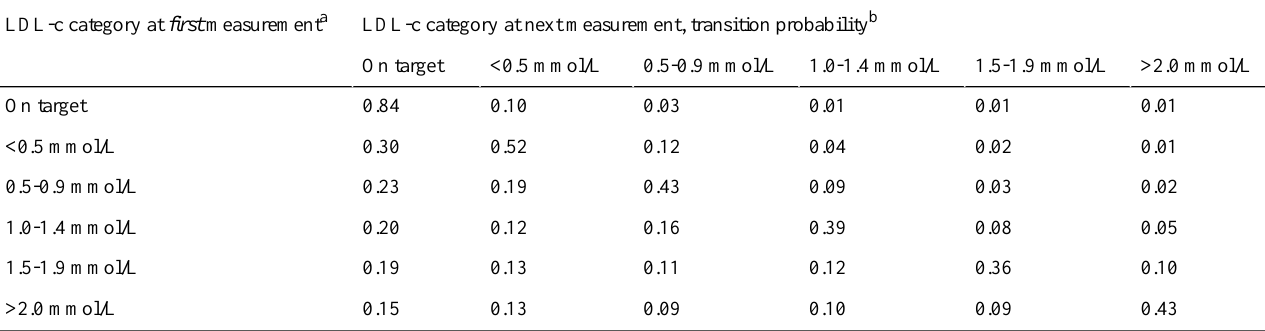
Table 3. Transition probabilities for low-density lipoprotein cholesterol (LDL-c) categories between measurement pairs. LDL-c category at next measurement, transition probability b LDL-c category at first measurement a